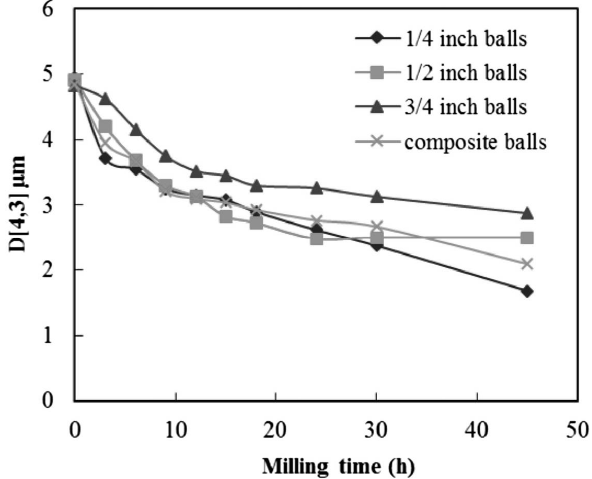
Figure 8. Effect of size of the balls on particle diameters as a function of milling time [82]. (RightsLink